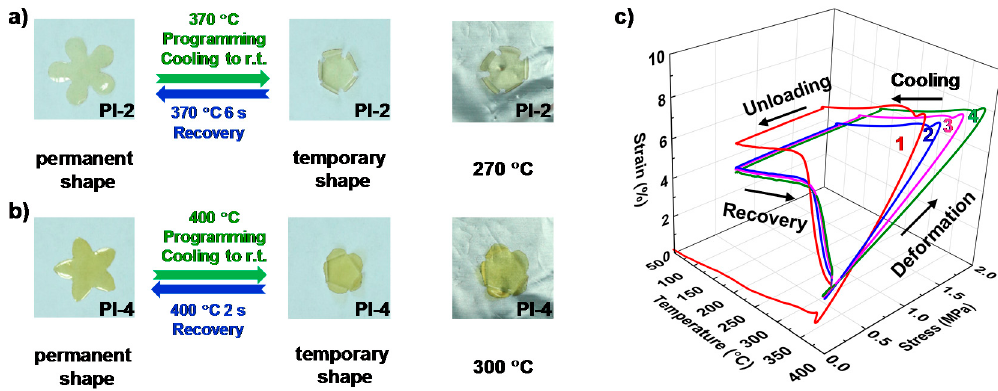
Figure 3. ( a ) Shape memory of flower-shaped PI-2 with thickness about 50 μ m. The permanent shape was placed on a hot stage at 370 ° C and bent with a certain angle, followed by cooling down to room temperature to fix the temporary shape. Then it recovered to permanent shape in 6 s when it was placed back onto the 370 ° C hot stage. It can keep the temporary shape on the 270 ° C hot stage. ( b ) Shape memory of flower-shaped PI-4 with thickness about 30 μ m. The permanent shape was placed on a hot stage at 400 ° C and bent with a certain angle, followed by cooling down to room temperature to fix the temporary shape. Then it recovered to permanent shape in 2 s when it was placed back into the 400 ° C hot stage. It can keep the temporary shape on the 300 ° C hot stage. ( c ) Shape memory cycle in TMA of PI-4. An external force was applied at 400 ° C to deform a specimen to a certain strain. Then the specimen was cooled down (20 ° C/min) to 200 ° C, the stress released, and the specimen equilibrated for 5 min and then reheated (10 ° C/min) to 400 ° C to trigger recovery.